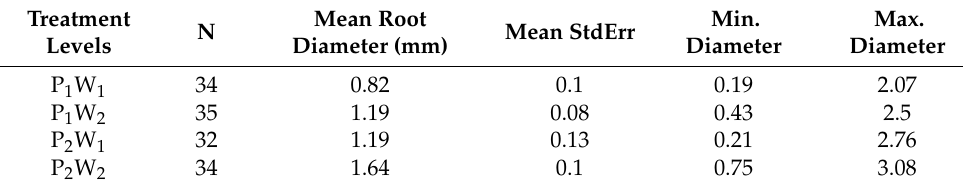
Table 12. Effects of phosphorus–water treatment on root diameter (mm) of common